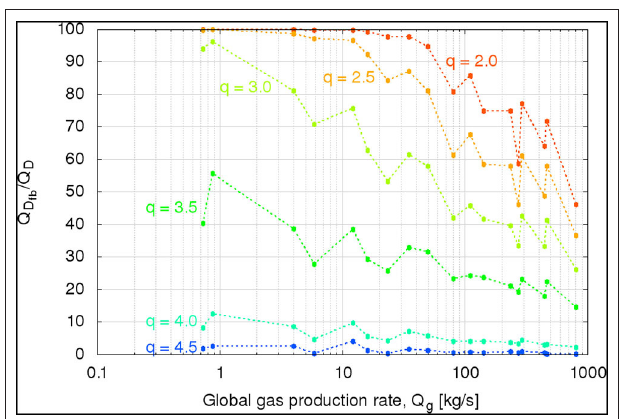
FIGURE 9 | The largest liftable dust size (red curve) and the largest escaping to total dust mass, Q D is fb dust size (blue curve) are shown as a function of the gas production rate.